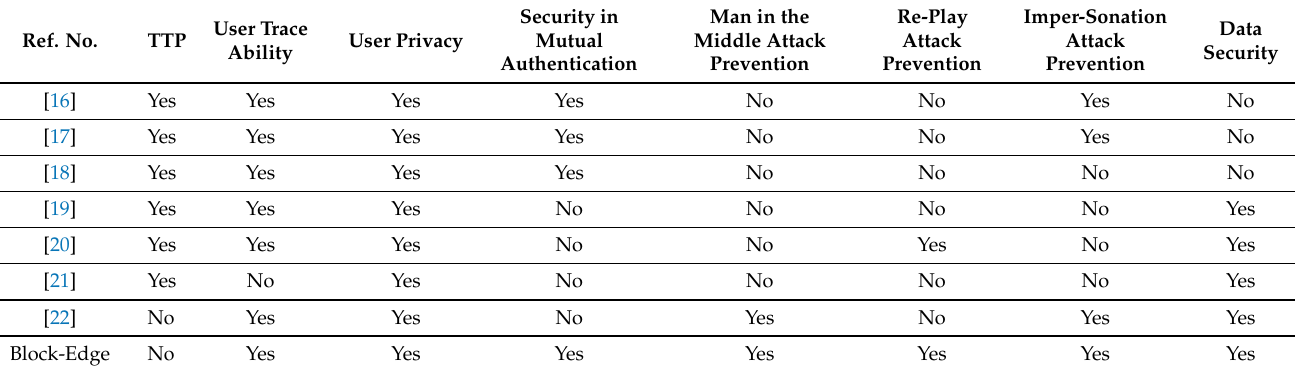
Table 2. Functionality comparison of the proposed block-edge approach with a few existing re- search works.